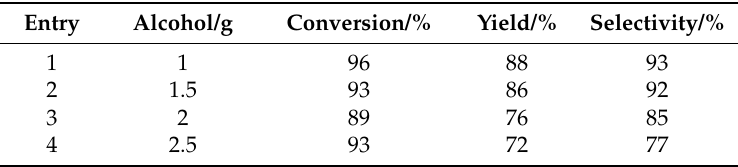
Table 3. Conversion of cyclohexanol into cyclohexylamine over Raney Ni with different amount of